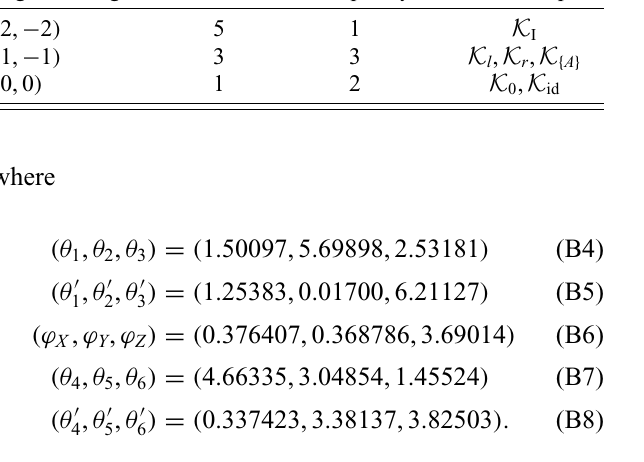
TABLE VIII. Irreducible representations for a single-qubit sys- tem. The definitions of the irreducible spaces are based on the irreps of the Clifford group given in Ref. [ 100], and are explained in the main text. Highest Weight Dimension Multiplicity